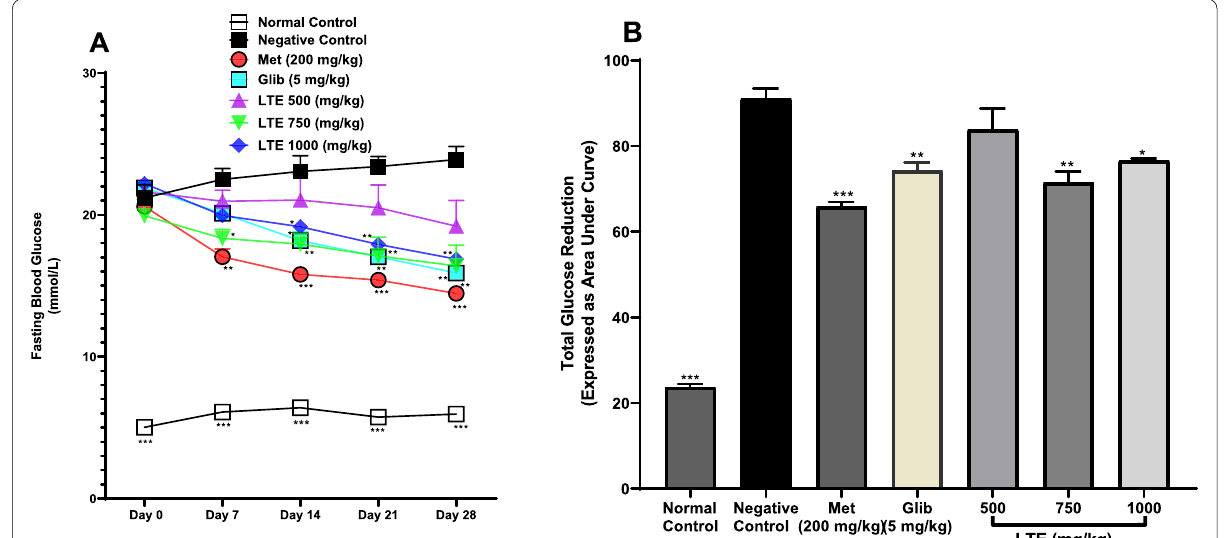
Fig. 2 Effects of LTE on Fasting Blood Glucose levels during the 28‑day treatments ( A ) vs. Total AUCs of the effects of the different treatments ( B ). Values were expressed as mean SEM ( n 5). Data were analyzed using two‑way ANOVA for 2A and one‑way ANOVA for 2B, followed by Dunnett’s ± = multiple comparisons test. * represents statistical significance at p < 0.05 vs. the negative control